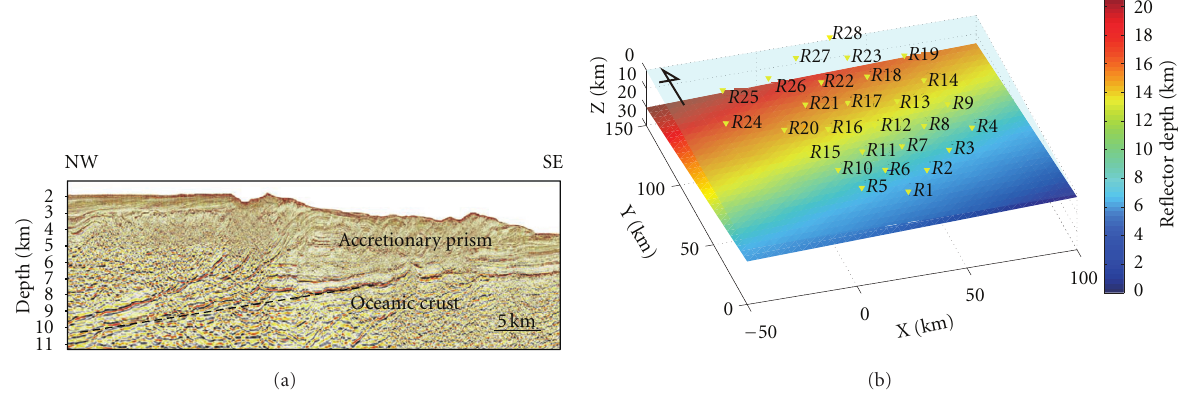
Figure 11: (a) 2D reflection profile across the Nankai Trough (Line IL in Figure 9(a), modified after Moore et al. [9]). Dashed line shows the angle of 5.5 degree. (b) Constructed 3D dipping structure for the raypath calculation.